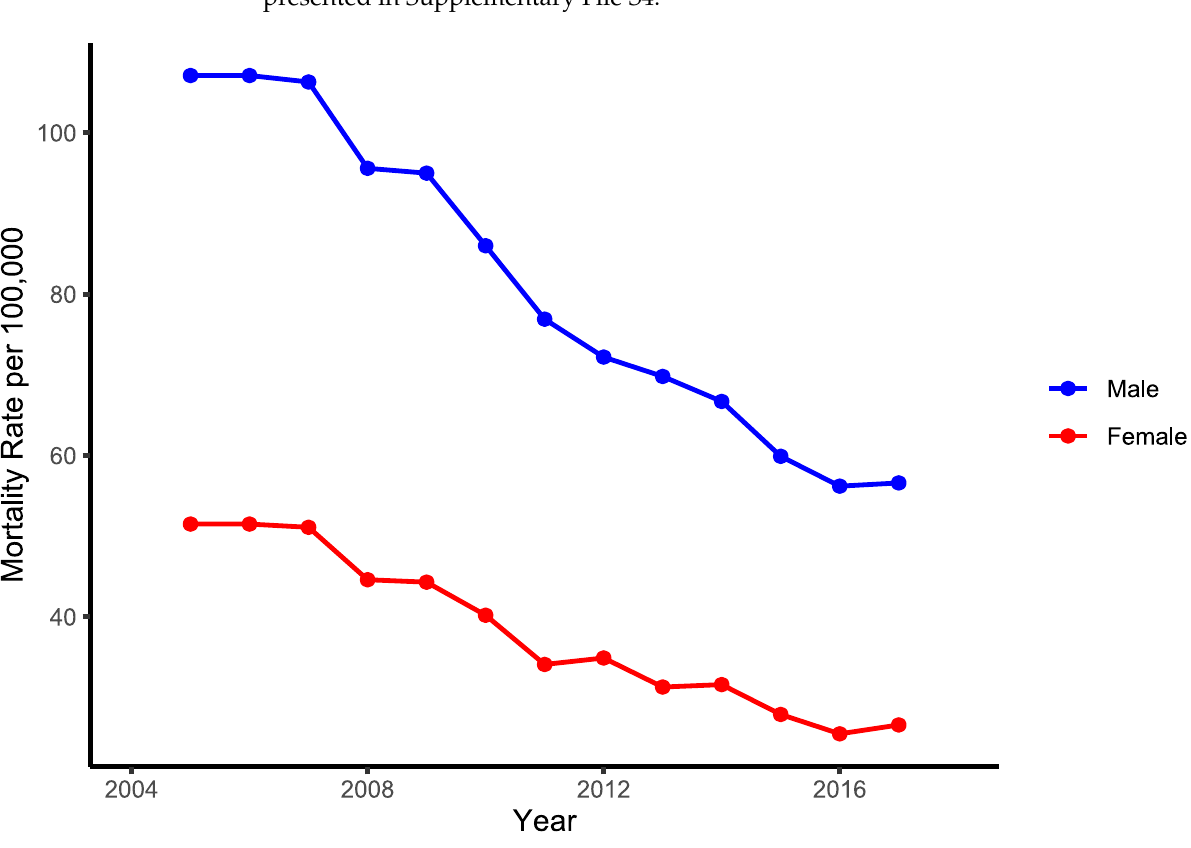
Figure 1. Joinpoint analysis: trends in age-specific mortality rates from acute coronary syndrome (per 100,000 persons) for males and females in Serbia, 2005–2019; Statistically significant trend. AAPC, average annual percent change; ASR, age-standardized rate (per 100,000 persons, using European standard population).